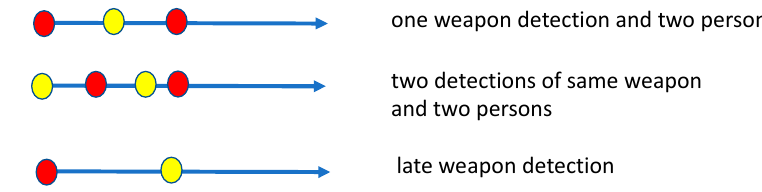
Figure 13. Critical scenarios for S1 & 2D Video (time-based) data fusion .